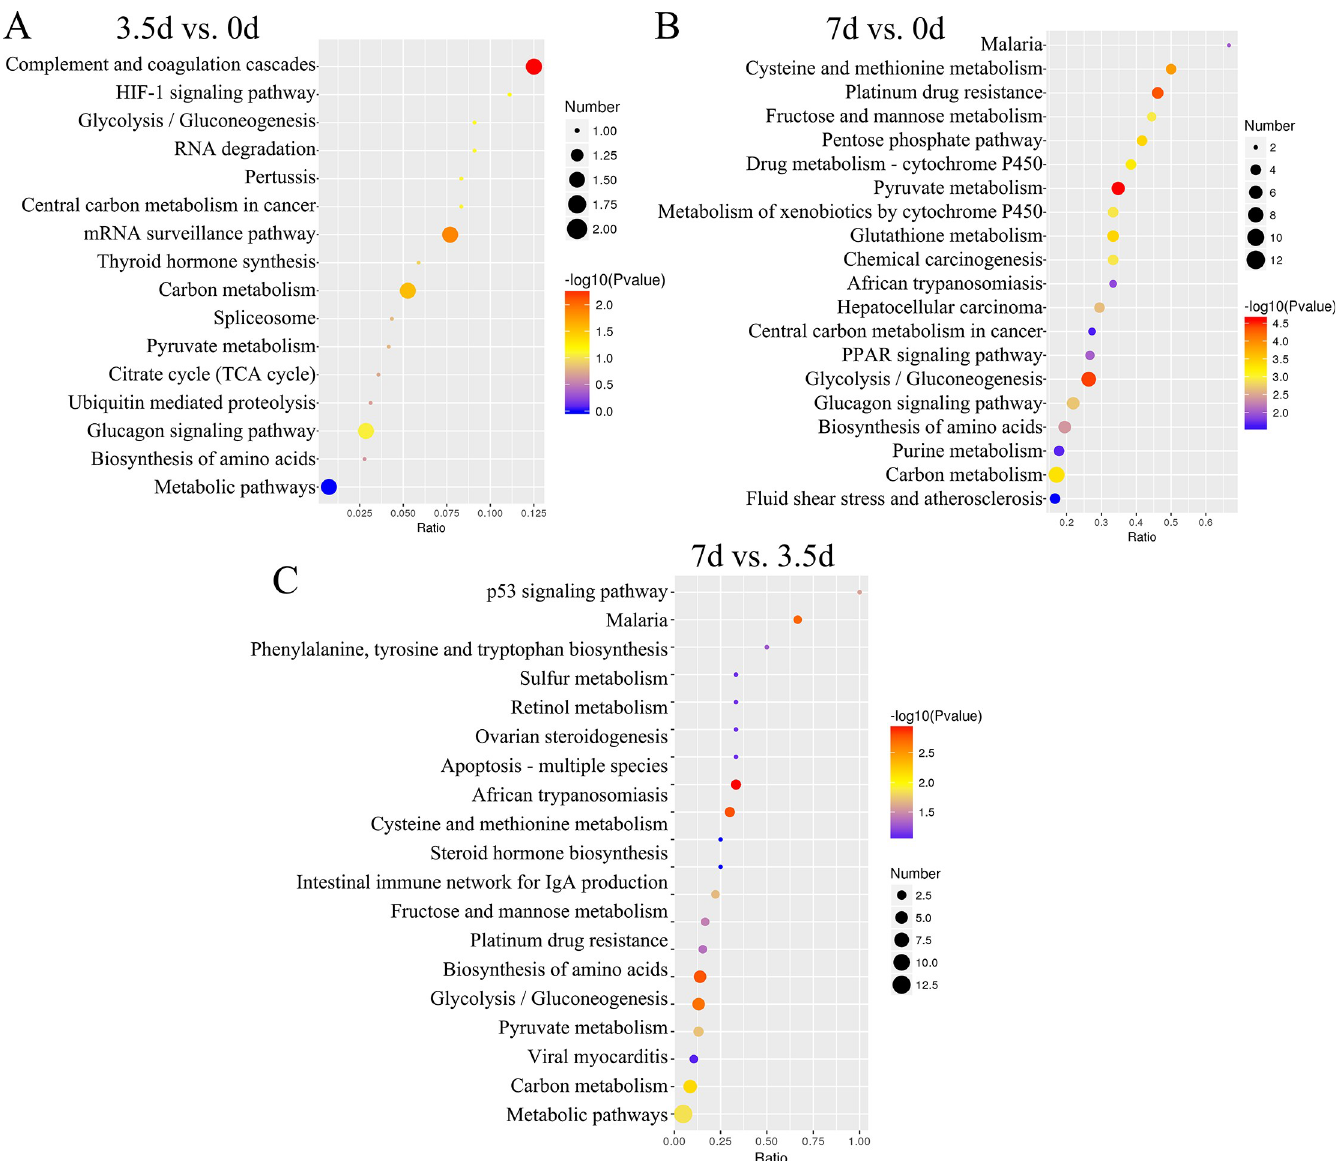
Fig 4. The KEGG enrichment pathway of the Differentially Expressed Proteins (DEPs). (A, B, and C), the KEGG pathways associated with DEPs between 3.5 d and 0 d, 7 d and 0 d, and 7 d and 3.5 d,